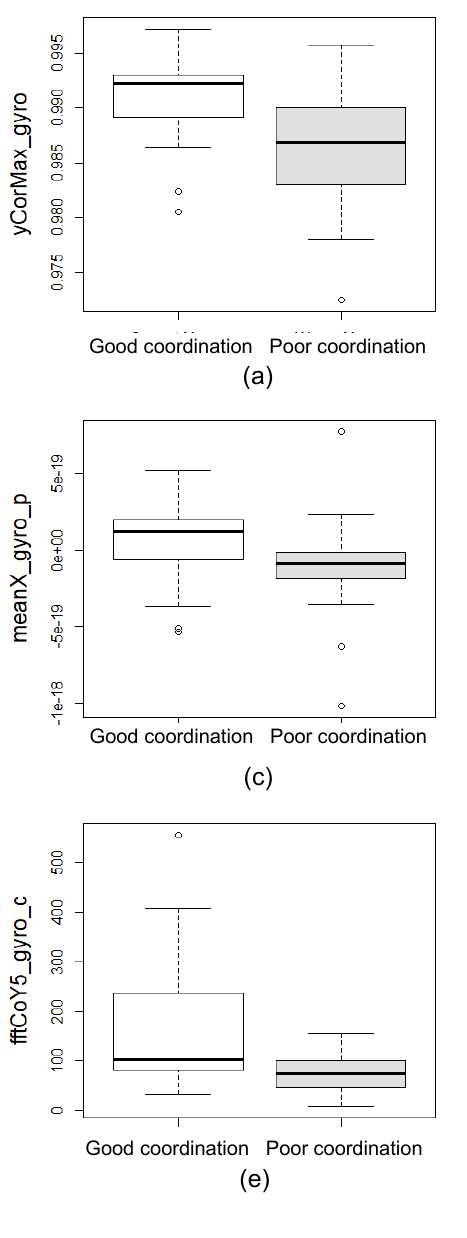
Figure 6. Box-and-Whisker plots on top five features selected in Method-9 for good and poor coordination during chest rotation: (a) maximal value of cross-correlation of y component of angular velocity between chest and pelvis; (b) fourth FFT coefficient of z component of angular velocity of chest; (c) mean value of x component of angular velocity of pelvis; (d) maximal value of cross-correlation of z component of angular velocity between chest and pelvis; (e) fifth FFT coefficient of y component of angular velocity of chest. Thick lines, bot edges and whiskers represent the median, the 25-75% quartile range and the overall range